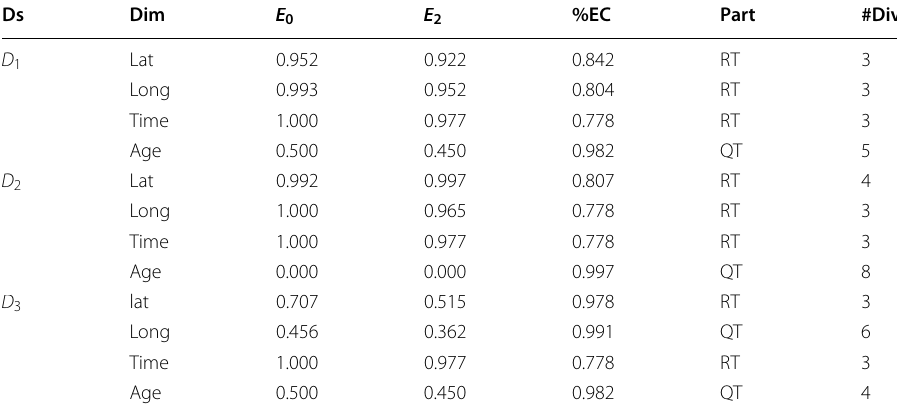
Table 1 Datasets characteristics